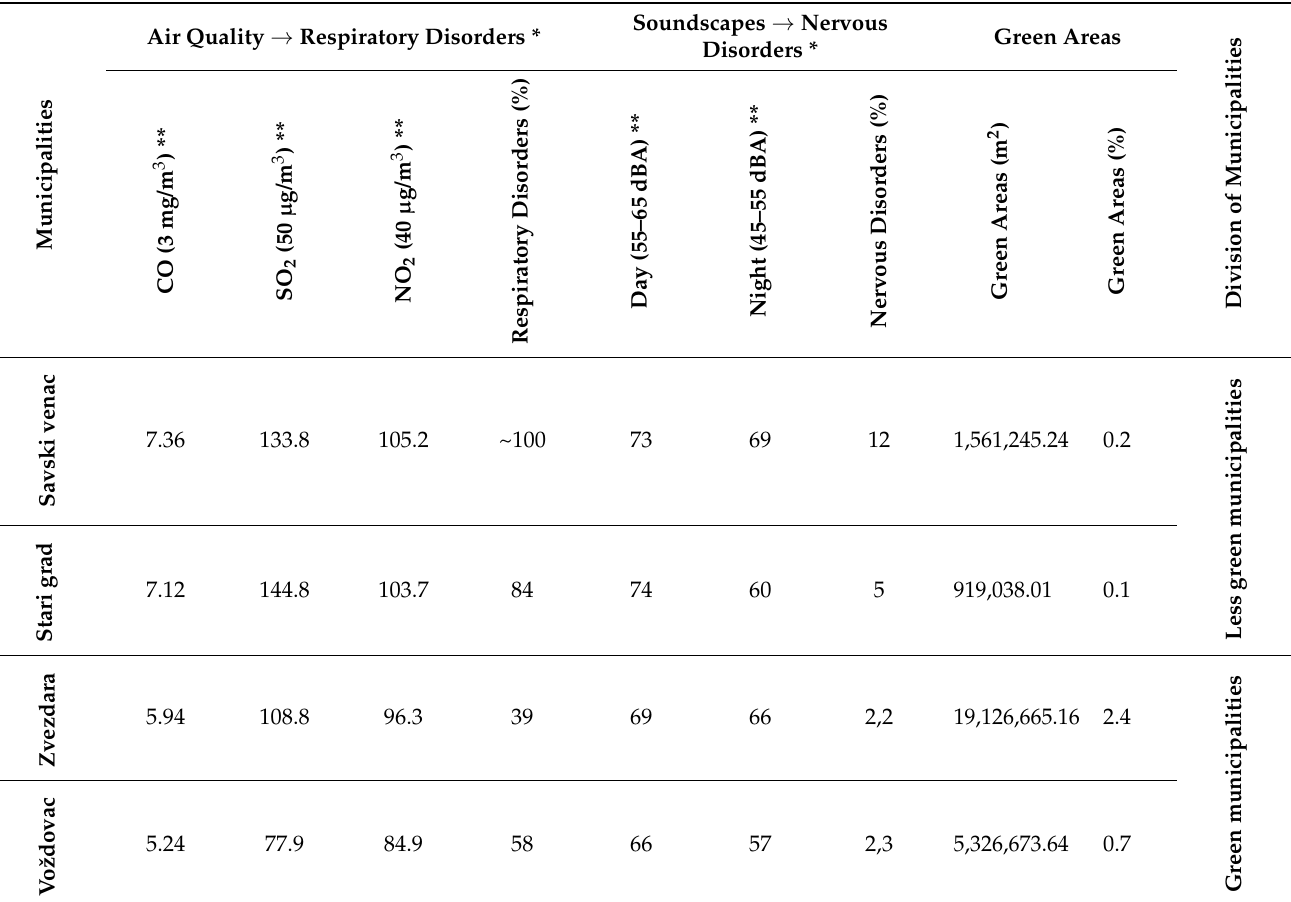
Table 2. Secondary environmental and related health data per municipality and data on green areas per municipality in relation to the total